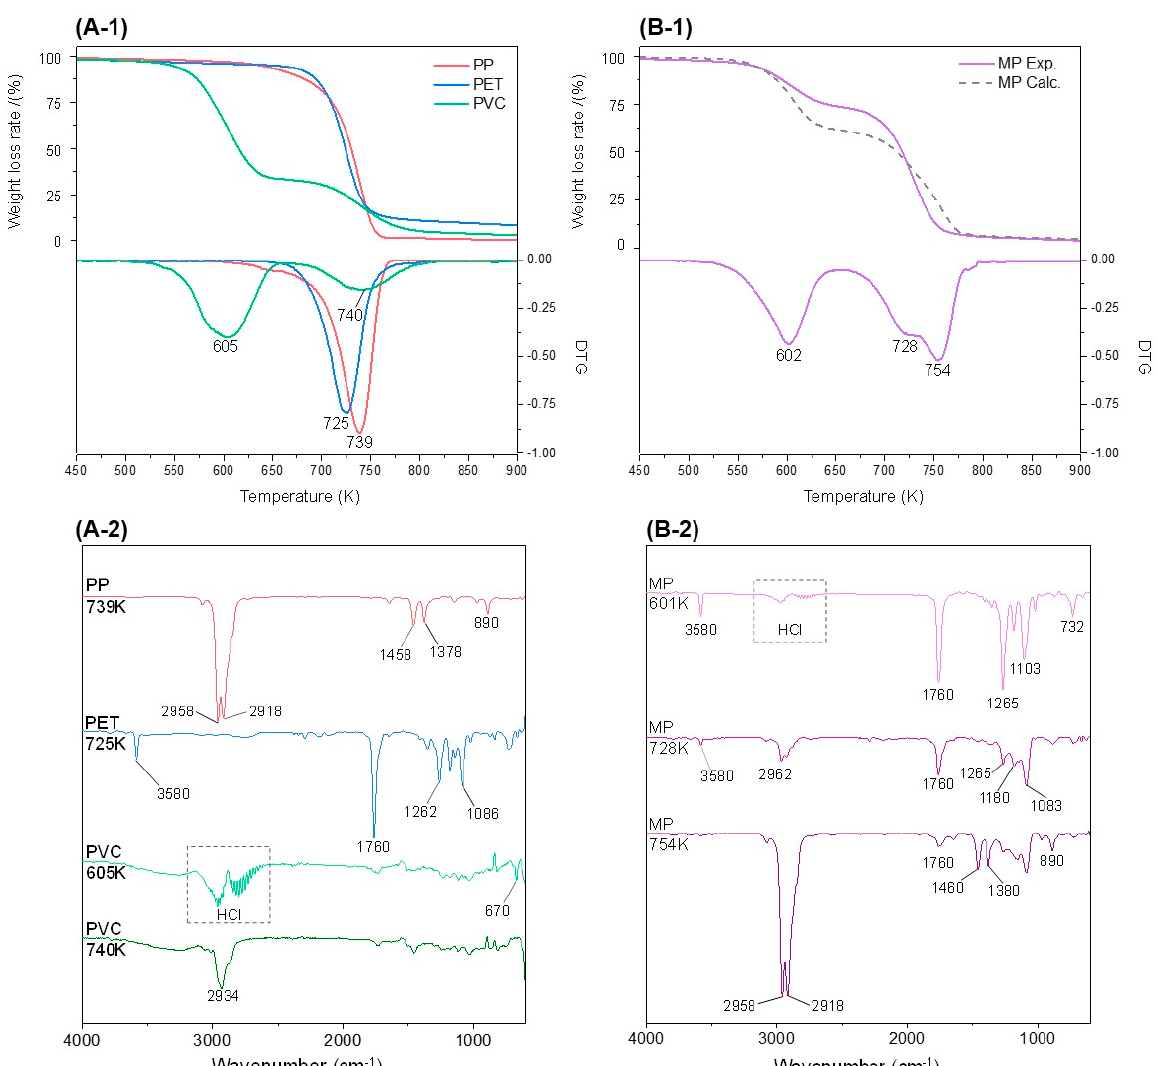
Figure 2. ( A-1 ) TG, DTG curves for pyrolysis of PP, PET, PVC; ( A - 2 ) independent FTIR spectra of PP, PET, and PVC; ( B-1 ) TG, DTG curves of MP; ( B-2 ) FTIR spectra for each temperature peak of MP.